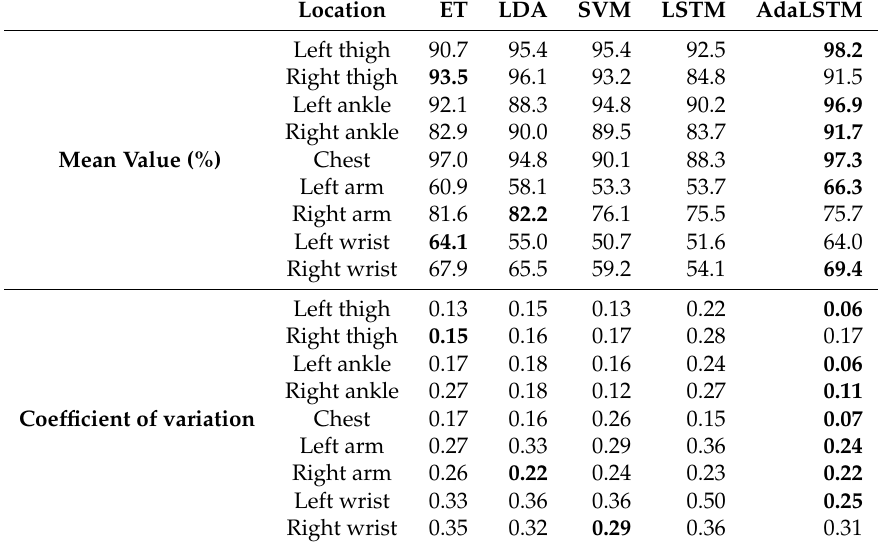
Table 4. Comparison between the mean value and coefficient of variation for F 1 score of detecting three lying postures for different sensor placements and classifiers including Ensemble Trees (ET), Linear Discriminator Analysis (LDA), LSTM with fixed learning rate (LSTM), and Adaptive LSTM (AdaLSTM) while using Class-Act Dataset. We show the highest F 1 score value, and lowest CoV metric that models could achieve for each location for LOSO validations in